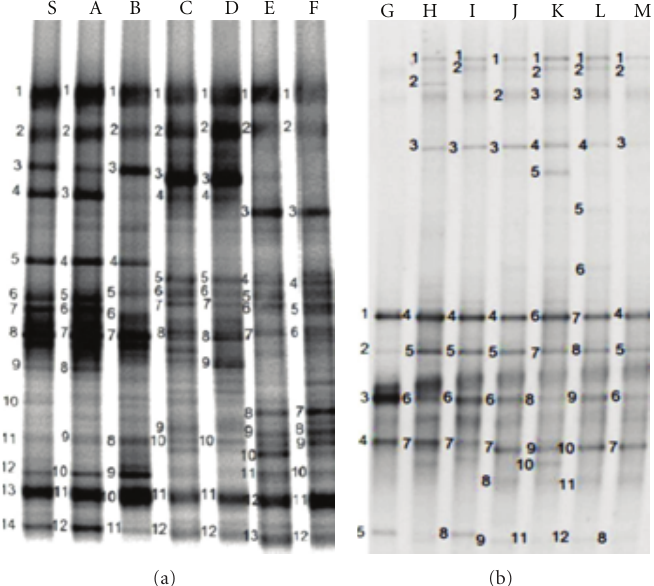
Figure 5: DGGE profiles of (a) EUB and (b) ARC of all reactor operations. Remark: (a) DGGE profile of EUB: S: startup seed; A: packed zone B: sludge zone at C1; C: packed zone and D: sludge zone at C2; E: packed zone and F: sludge zone at C3; (b) DGGE profile of ARC: G: startup seed; H: packed zone and I: sludge zone at C1; J: packed zone and K: sludge zone at C2; L: packed zone and M: sludge zone at